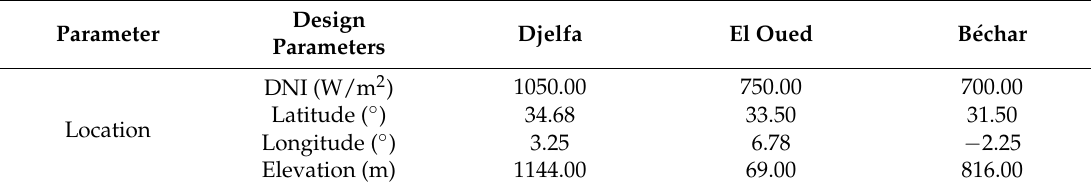
Table 1. Location parameters for different regions.